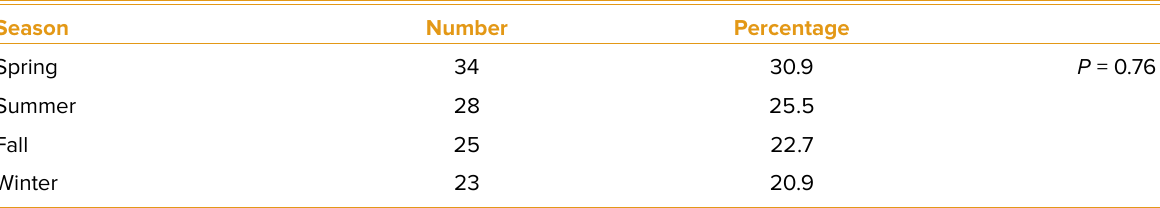
Table 1. Number of OGI by season.